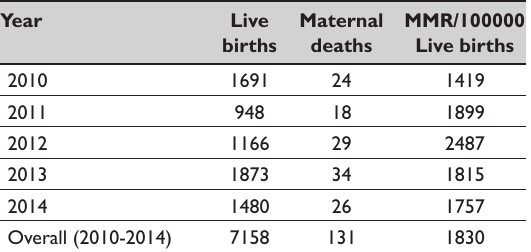
Table 1: Annual distribution of maternal mortality ratio